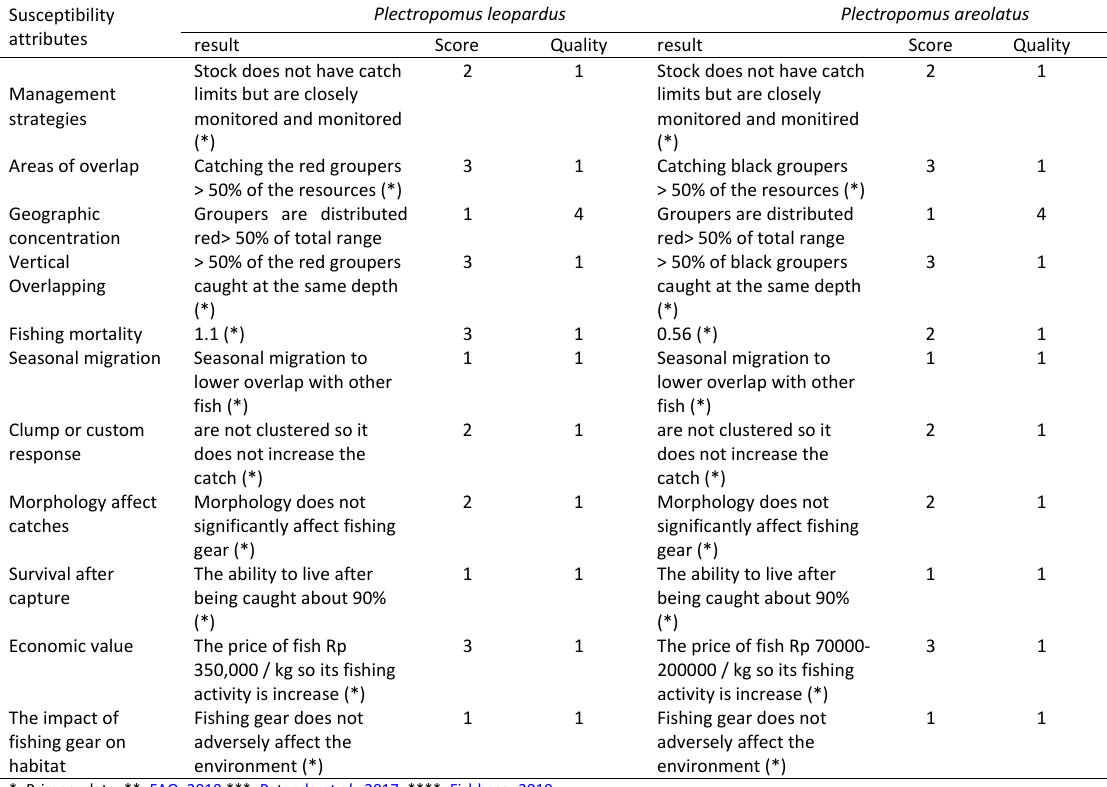
Table 4: Susceptibility attributes of red and black groupers at Wakatobi National Park